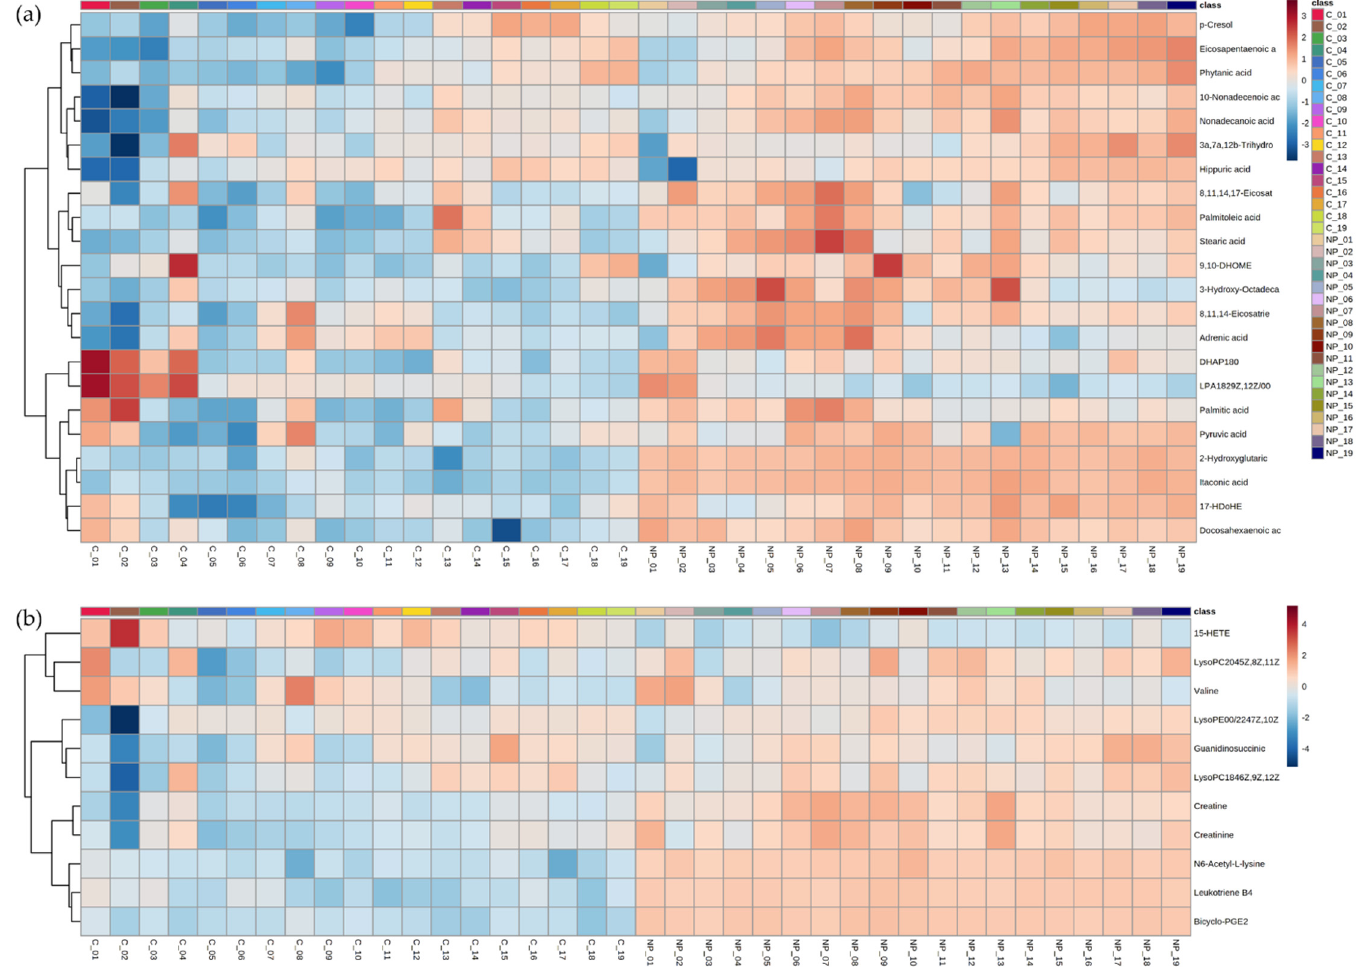
Figure 3. Hierarchical cluster analysis (HCA) of the major metabolite changes differentiating naturally MAP-infected from control heifers between ~1 month and 19 months of age in the ( a ) negative ionization and ( b ) positive ionization mode; C = control heifer, NP = naturally MAP-infected heifer.